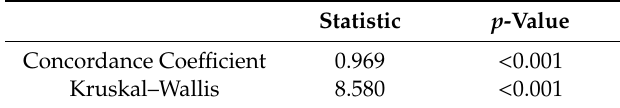
Table 8. Kruskal–Wallis and concordance test for Fa.